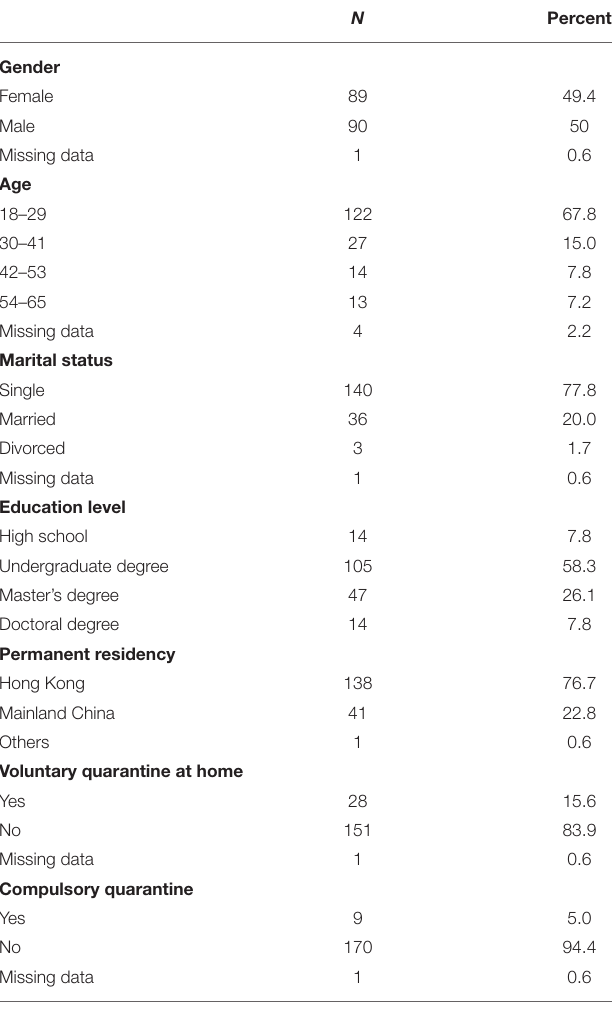
TABLE 1 | Descriptive statistics of the study participants’ demographic information ( N =